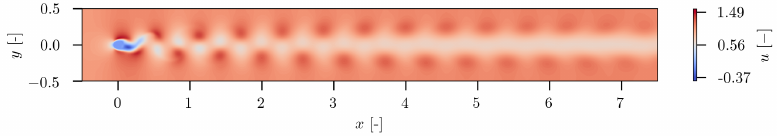
Figure 1. Flow field in the wake of cylinder during the periodic quasi steady state.